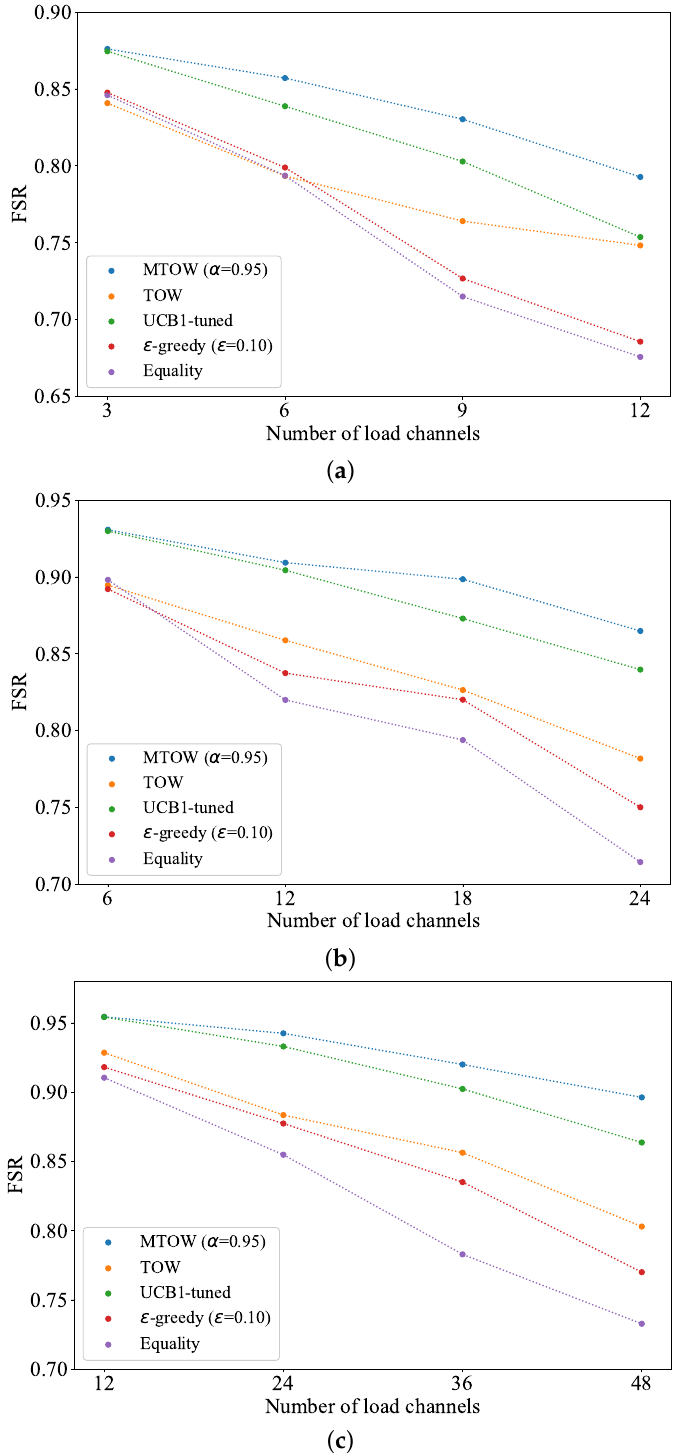
Figure 10. Number of load channels vs. FSR in the IoT network where the number of IoT nodes is 10,000 with λ = 0.8 and a duty ratio of 0.5. ( a ) Number of load channels vs. FSR when the number of available channels is 15. ( b ) Number of load channels vs. FSR when the number of available channels is 30. ( c ) Number of load channels vs. FSR when the number of available channels is